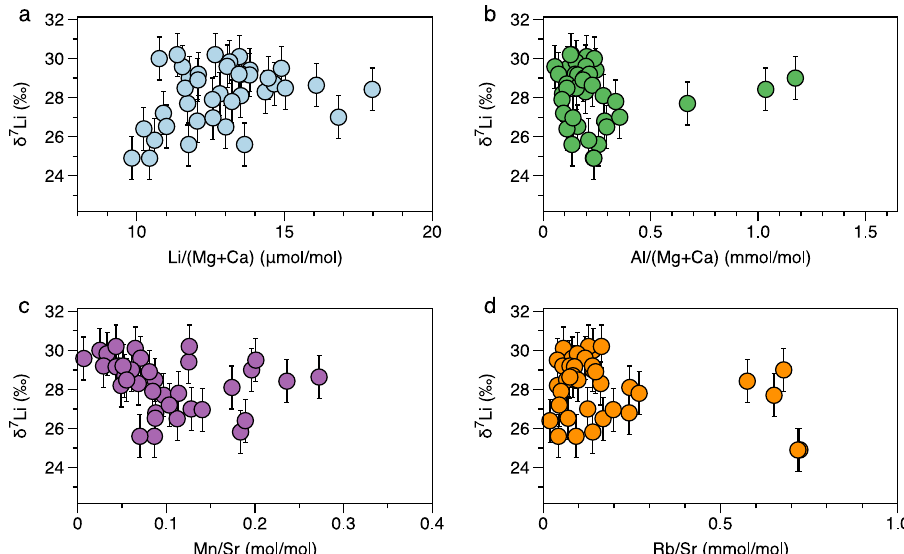
Fig. 3 Dolomitization and detrital contamination evaluations of δ 7 Li in dolostones plotted against elemental ratios. a δ 7 Li vs. Li/(Mg + Ca), b δ 7 Li vs. Al/(Mg + Ca), c δ 7 Li vs. Mn/Sr, d δ 7 Li vs. Rb/Sr. Error bars are 1.1 ‰ (2 SD) 29 .